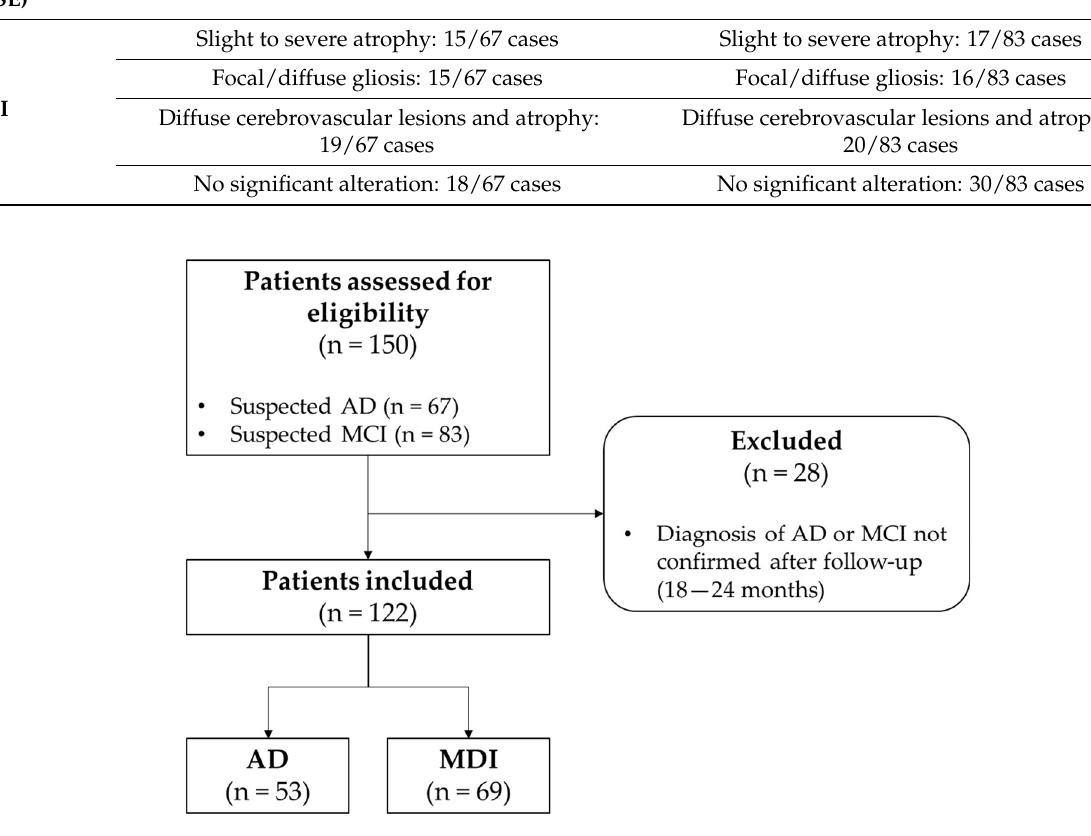
Table 1. Demographic, clinical, Mini Mental State Examination (MMSE) and Magnetic Resonance Imaging (MRI) data of Alzheimer Disease (AD) and Mild Cognitive Impairment (MCI) patients.